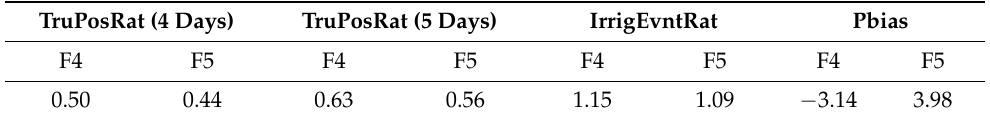
Table 2. Statistical metrics of the estimated irrigation over the flood irrigated F2 and F3 when assimilating S1-derived SSM for a 12-day window.